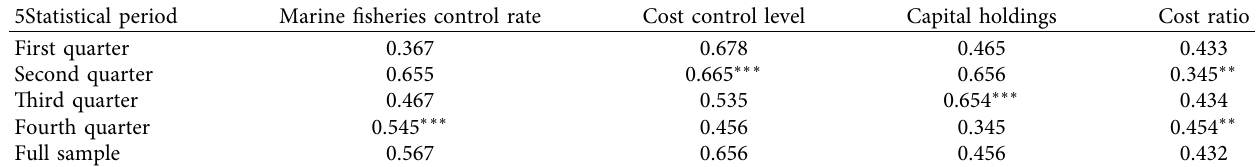
Table 2: Descriptive statistical analysis of marine fisheries culture control.